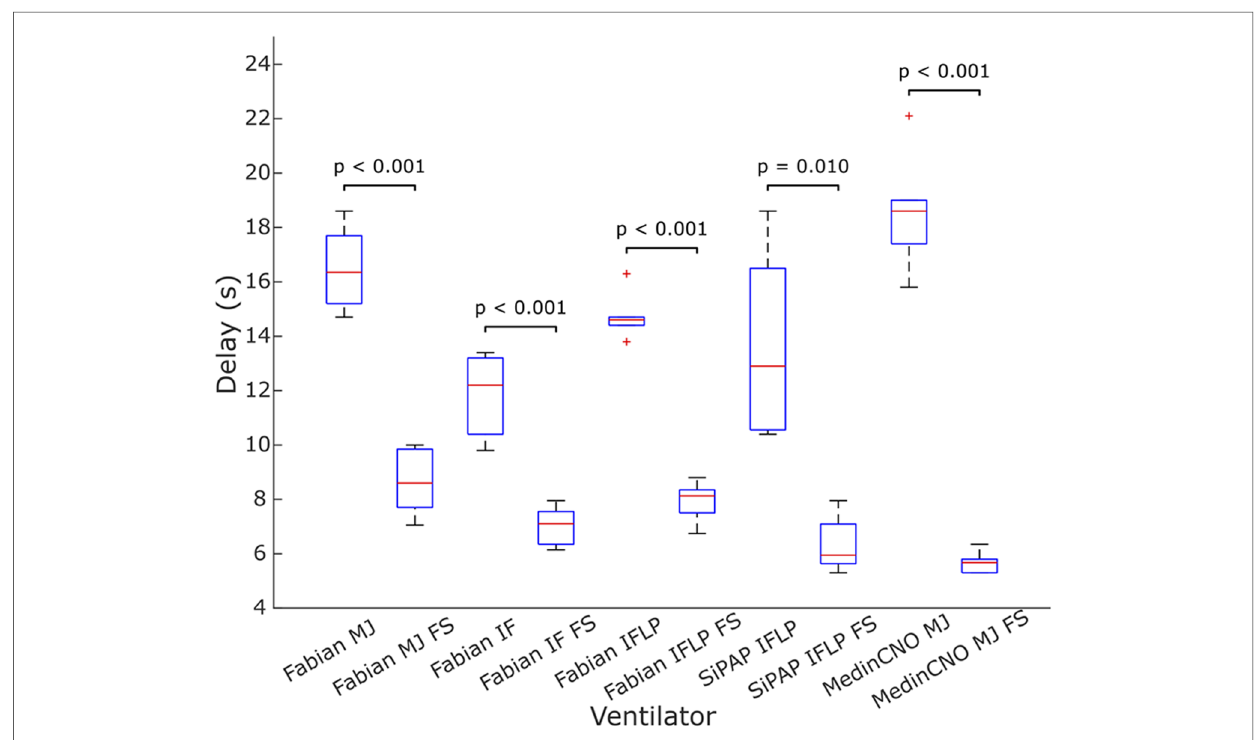
FIGURE 7 Delay in oxygen delivery upon a 10% increase in FiO 2 without the O 2 -FS and with the O 2 -FS. Fabian MJ, Fabian with Medijet interface, Fabian IF, Fabian with Infant Flow interface, Fabian IFLP, Fabian with Infant Flow Low Pressure; SiPAP IFLP, Vyaire SiPAP with Infant Flow Low Pressure interface; Medin MJ, Medin MedinCNO with Medijet interface. FS marks a con fi guration with the O 2 -FS. Each box plot displays the following information: median (red line), lower and upper quartiles (blue rectangles), outliers (red crosses), and minimum and maximum values that are not outliers (black